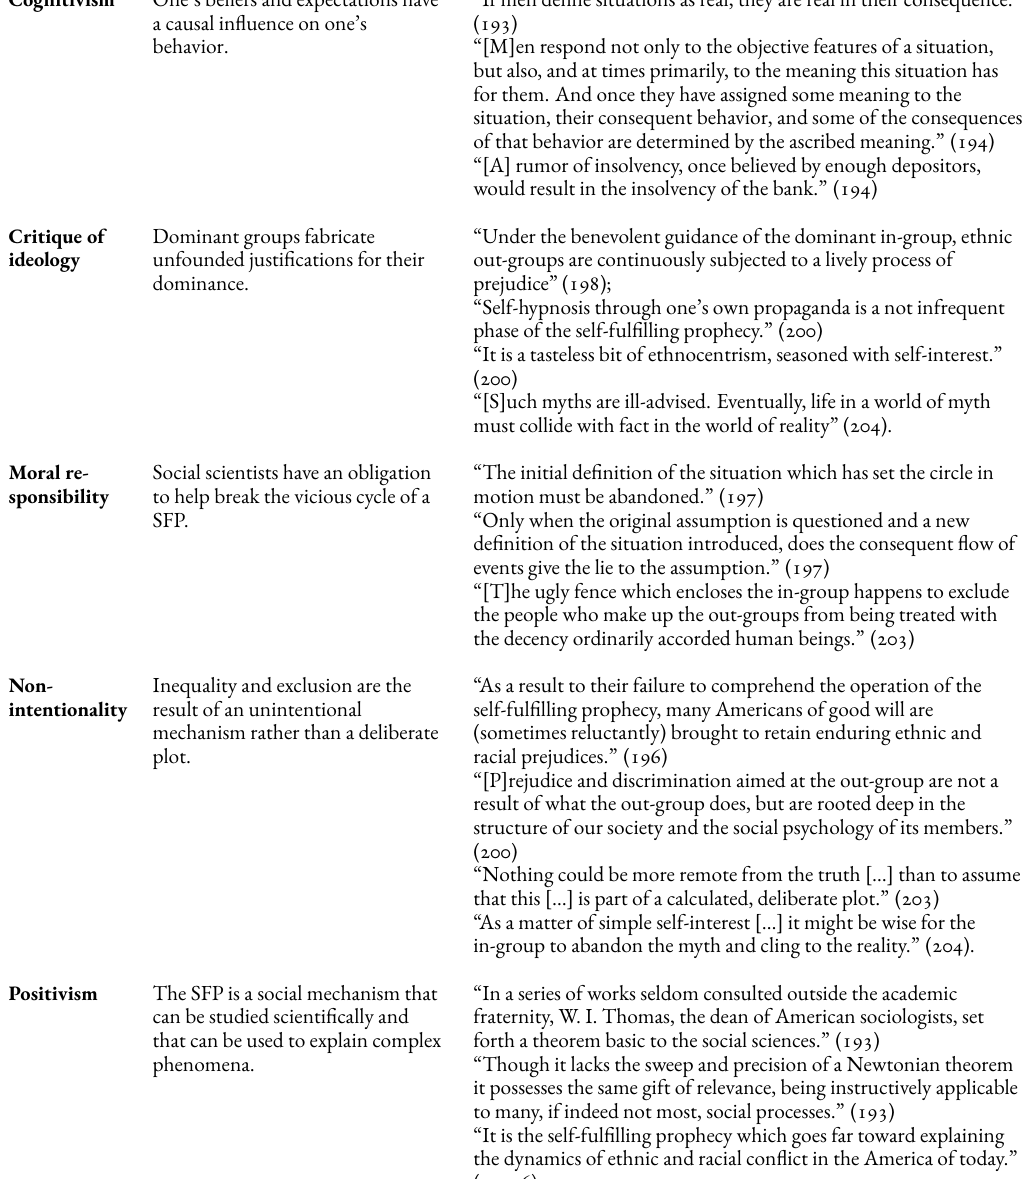
Table 1: Theoretical components of the